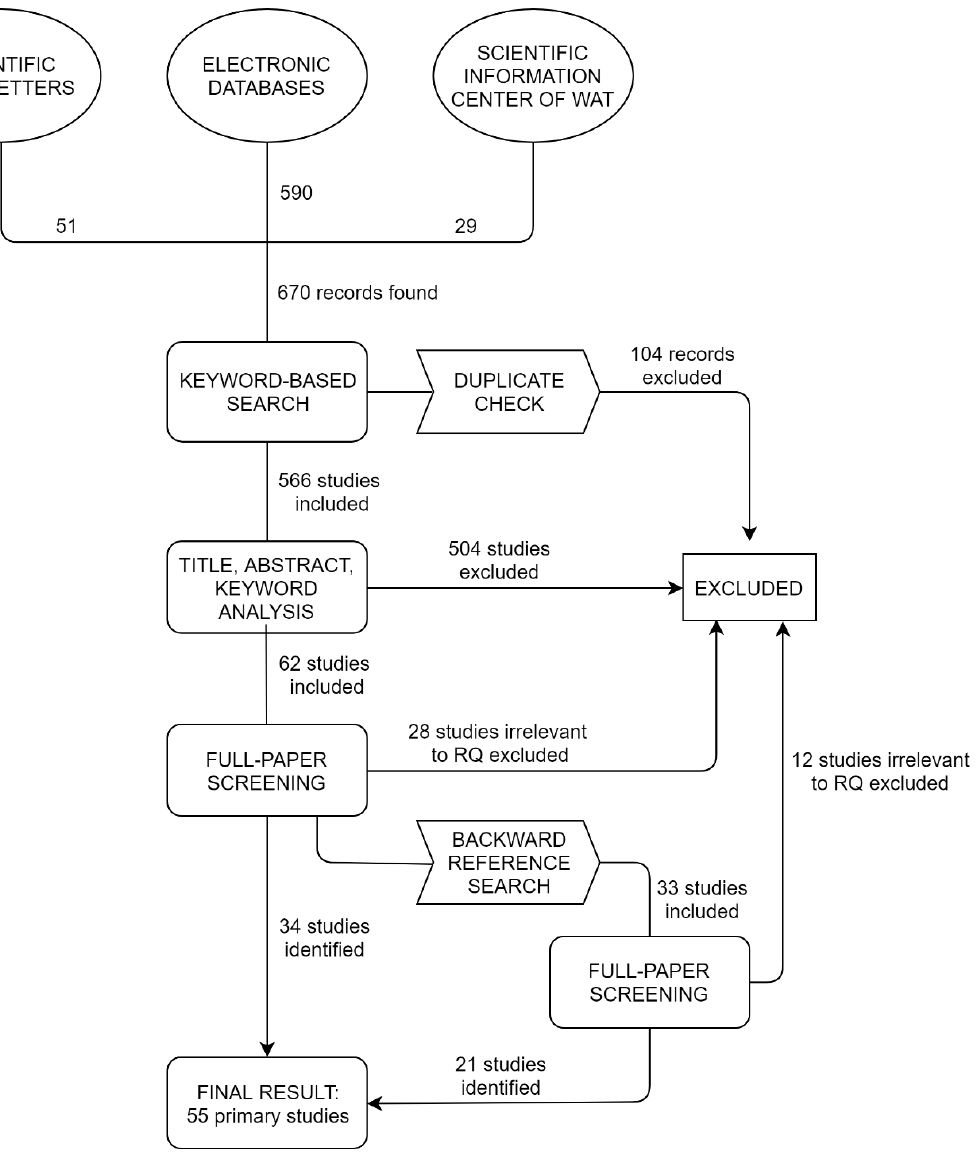
Figure 1. The course of the selection process together with the number of included and excluded papers in each step (source: own study).